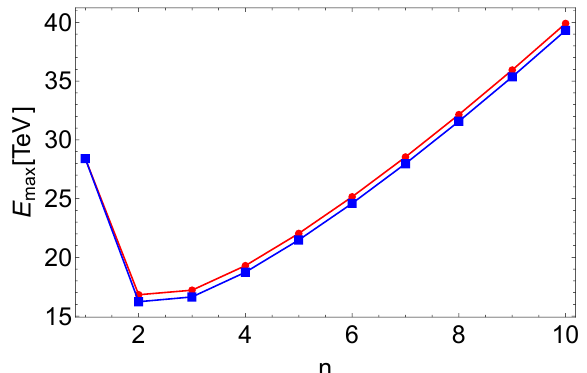
Figure 5 . The unitarity-violating scale as a function of n from γ ± h n → γ ∓ h n (blue), and γ ± γ ± h n − 1 → h n +1 (red). The former processes are dominant for all n . Here δ γ 2 n is set to 1